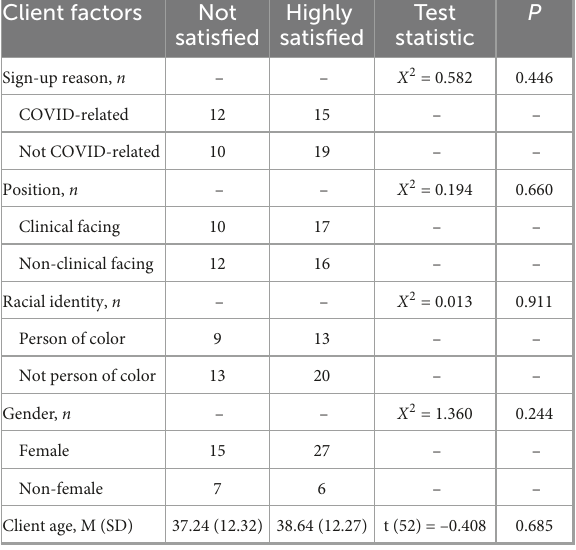
TABLE 3 Chi-square analysis of client survey respondent satisfaction and hypothesized background factors 1